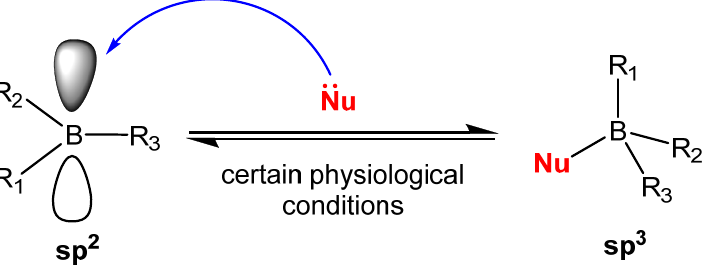
Figure 4. The transition of boron-containing moieties from trigonal planar geometry into tetrahedral geometry under some physiological conditions.